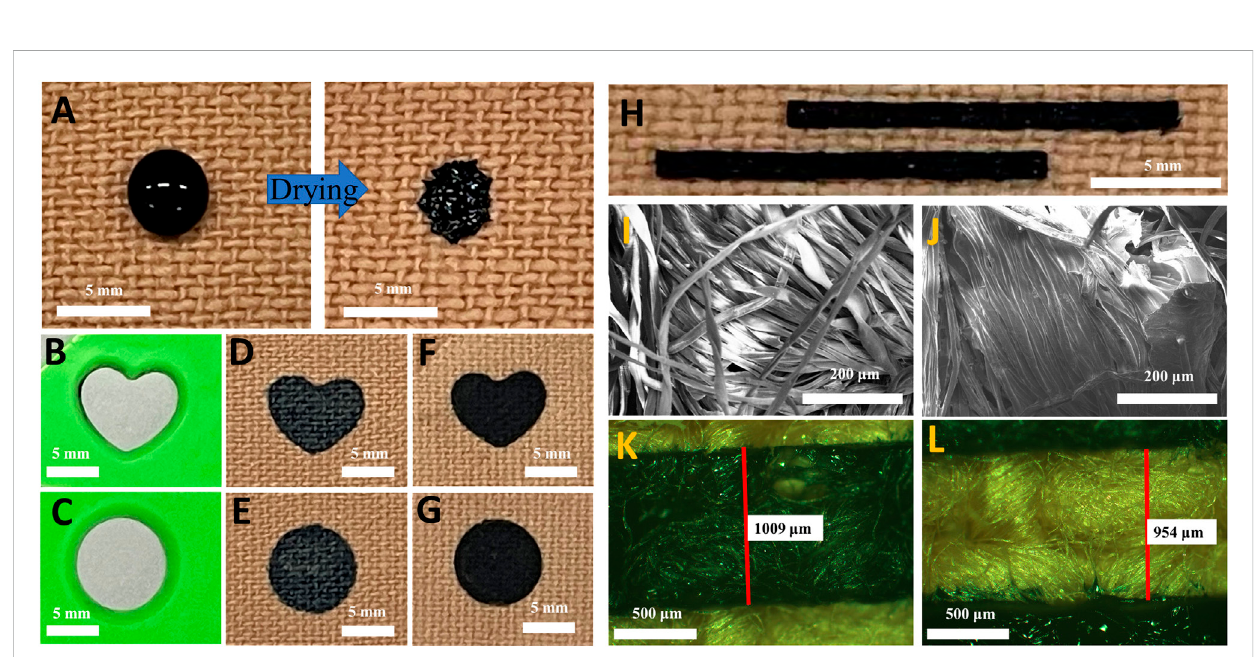
Patterning theplanar electrodes on themedical tape. Photos: (A) theDMSO doped PEDOT:PSS droplet before and after drying on themedical tape. (B) Heart-shapedmask. (C) Circularmask. (D,E) Heart-shapedandcircularPEDOT:PSSpatternsonmedicaltape. (F,G) Heart-shapedandcircularMXene patterns on medical tape. (H) A pair of planar PEDOT:PSS electrodes on medical tape. SEM images of the medical tape (I) before and (J) after PEDOT:PSS coating. Optical images showing (K) width of the PEDOT:PSS electrode and (L) the interspace between two electrodes.